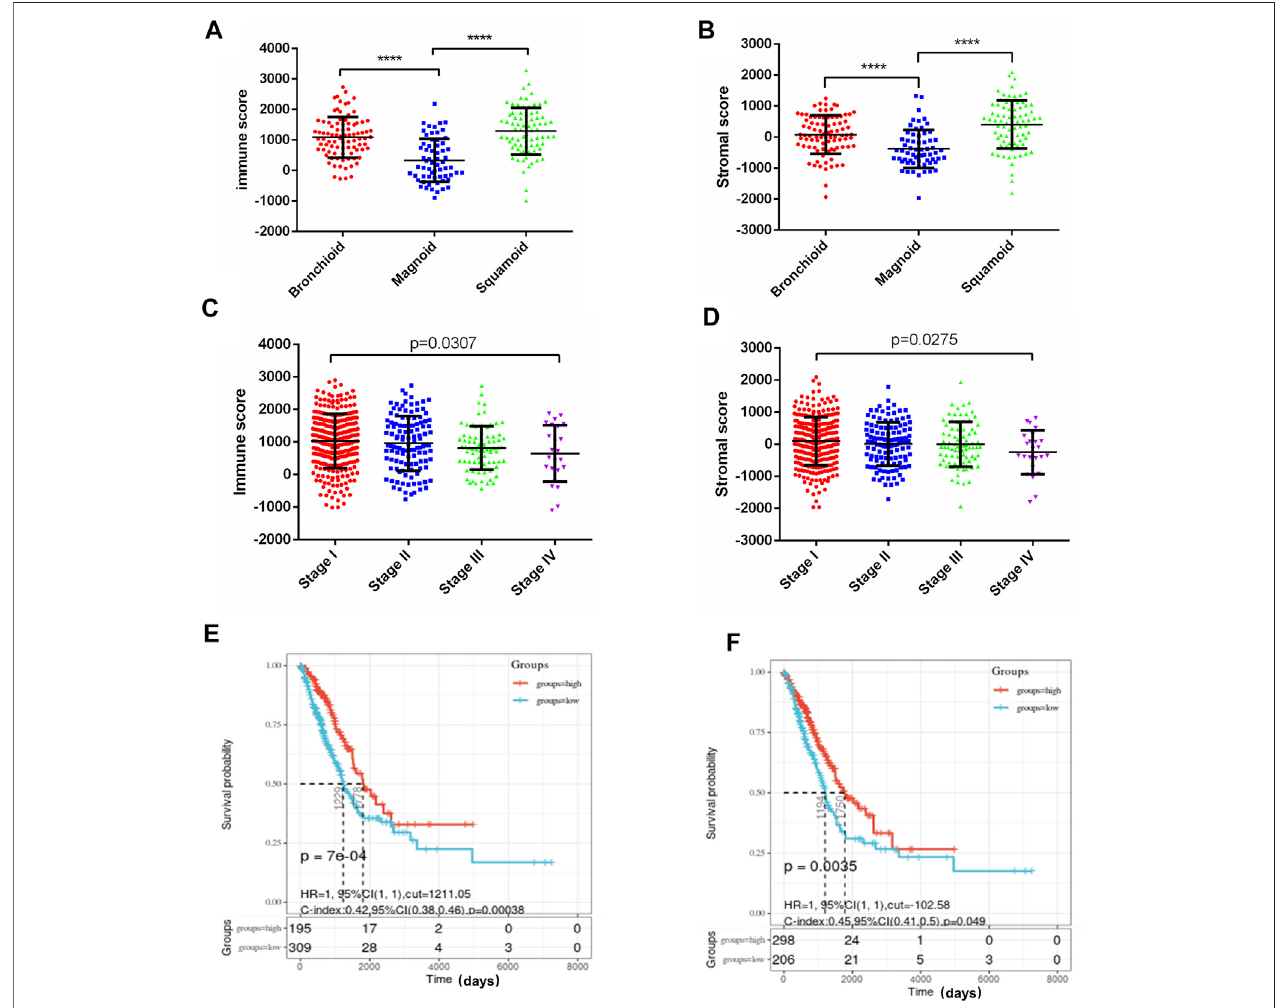
FIGURE1| ImmunescoresandstromalscoresareassociatedwithLUADsubtypes,clinicalstage,andsurvival. (A) DistributionofimmunescoresinLUADmolecular subtypes.Box-plotshowsasigni fi cantassociationbetween molecularsubtypesandthelevelofimmunescores( n = 516, p < 0.001). (B) Distributionofstromalscoresof LUAD molecular subtypes. Box-plot shows a signi fi cant association between LUAD molecular subtypes and the level of stromal scores ( n = 516, p < 0.001). (C) Distribution of immune scores for LUAD clinical stage. Box-plot shows a signi fi cant association between the clinical stage and the level of immune scores ( n = 516, p = 0.0307). (D) Distribution ofstromal scores forLUADclinical stage. Box-plot showsa signi fi cantassociation betweenthe clinicalstageand thelevelof immune scores ( n = 516, p = 0.0275). (E) The Kaplan-Meier survival curve showed the overall survival of the high score group is longer than the low score group, p = 7e-04. (F)